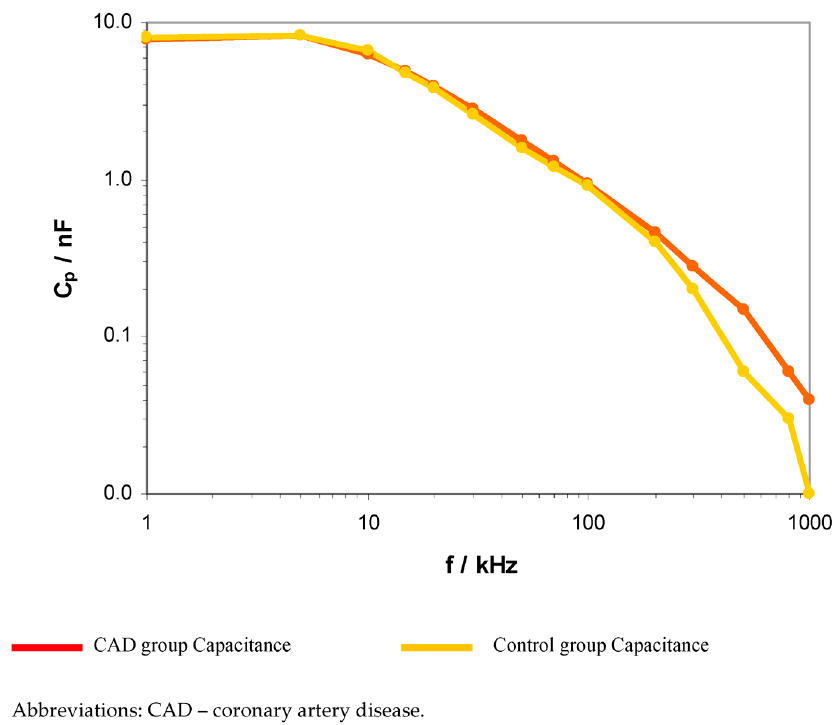
Figure 1. Logarithmic comparison of EIS resistance between CAD and control group within the range from 1 kHz to 1 MHz.